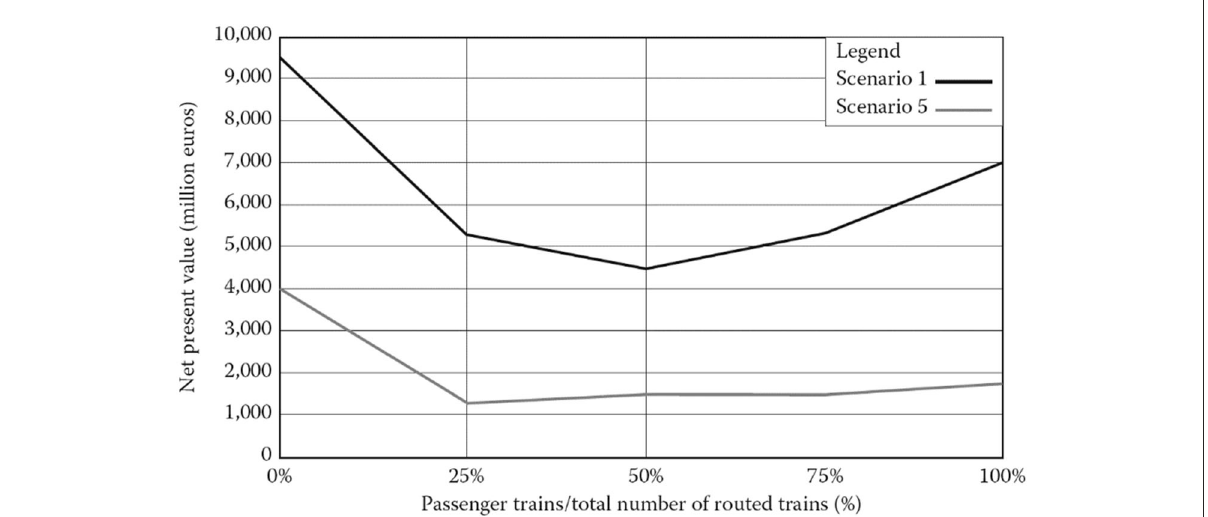
FIGURE3 Variation of the NPV in relation to the traffic composition – Scenarios S1 (double track) and S2 (single track) (Christogiannis and Pyrgidis, 2014).